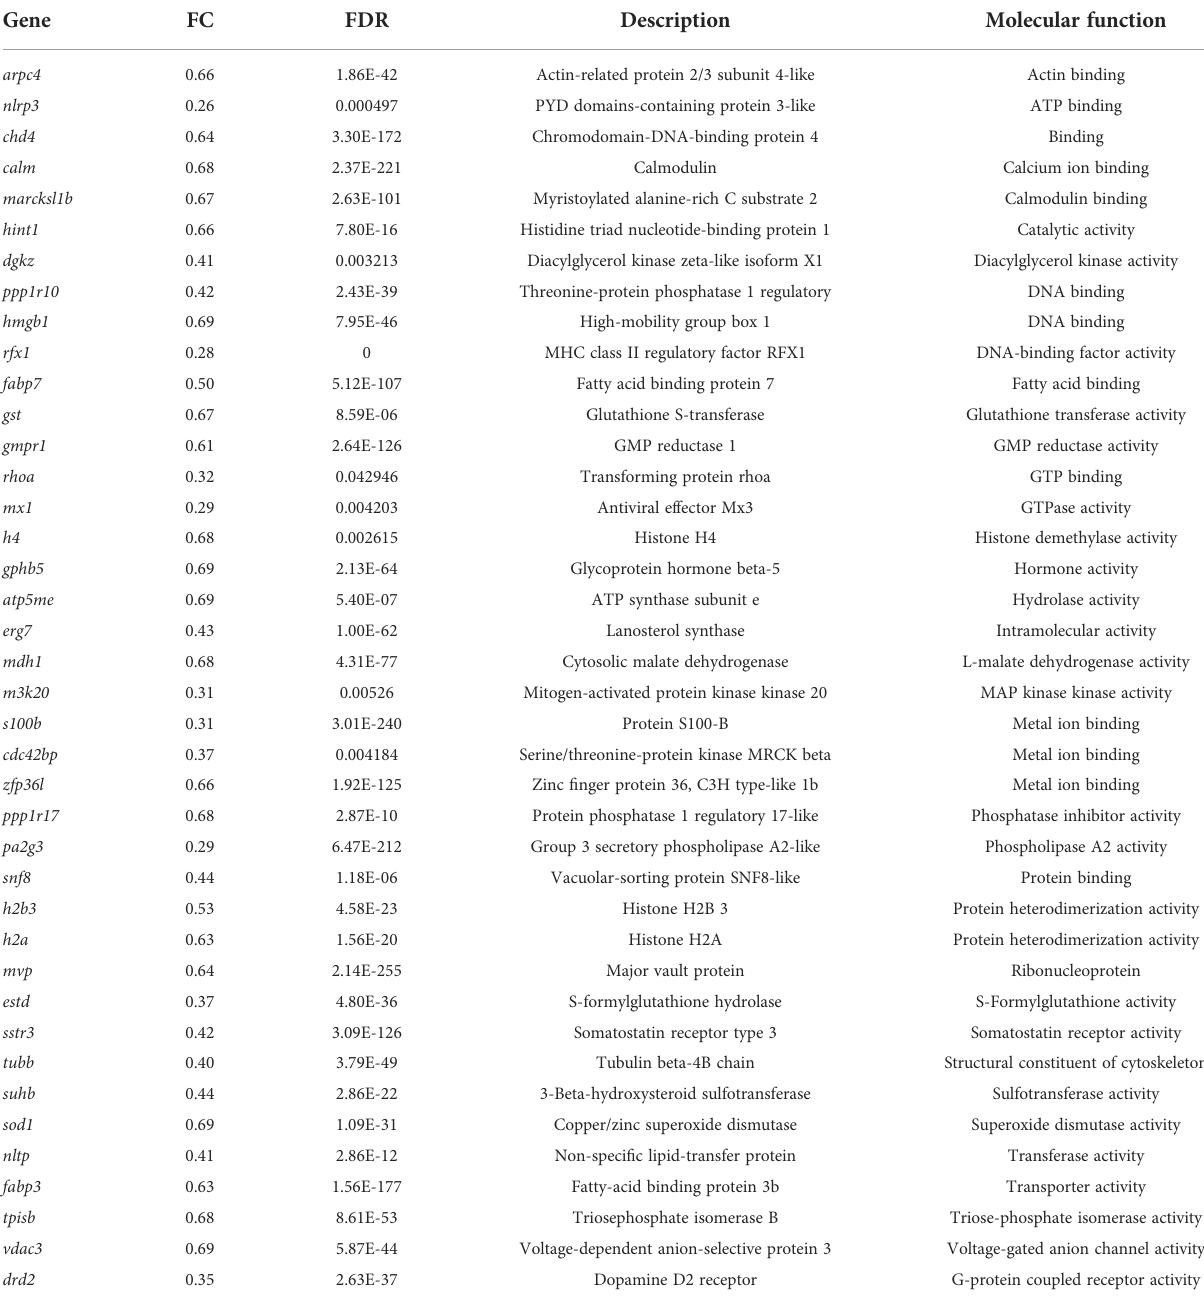
TABLE 2 Downregulated genes by GnRH3 in grass carp pituitary